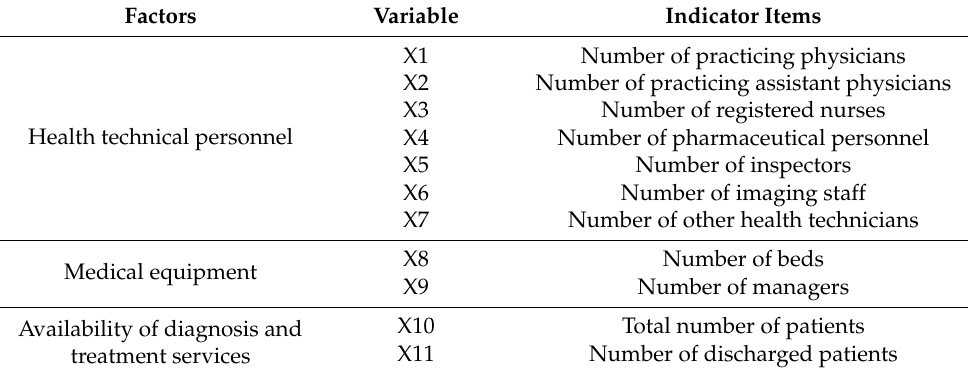
Table 4. Evaluation indicators of the levels of Changxing medical